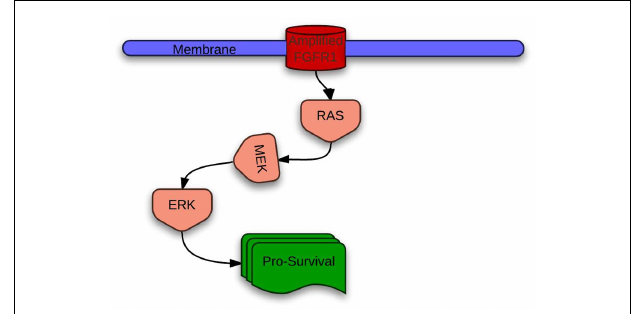
FIGURE 3 | Predominant intracellular signaling from amplified FGFR1 in lung cancer